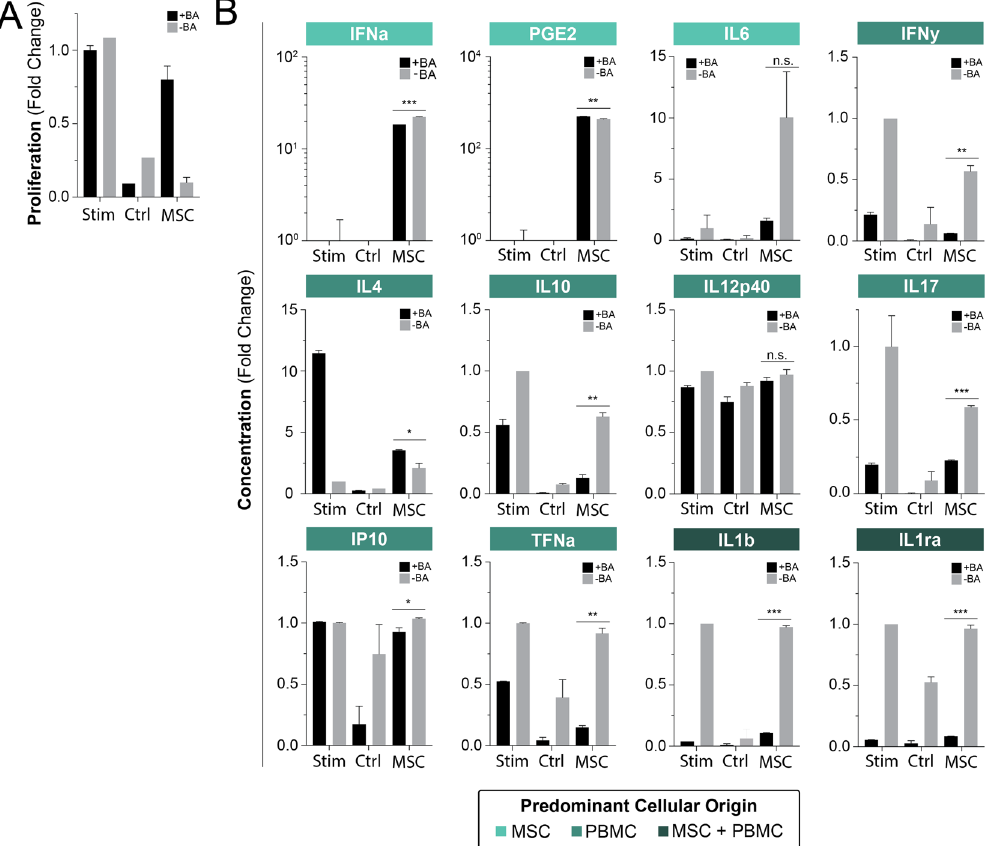
Figure 5. MSC:PBMC cross communication is critical as shown by the use of a protein transport inhibitor. PBMCs were treated for 24 hours with Brefeldin A prior to the start of co-culture; + BA indicates with brefeldin A pretreatment, -BA indicates without brefeldin A pretreatment. PBMC proliferation was attained through stimulation with ConA and IL2 for a period of 4 days. Proliferation was measured through flow cytometry and CFSE staining; bar graphs represent mean + / − SD of 3 samples. ( A ) Bar graphs of normalized proliferation versus Brefeldin A conditions. ( B ) Bar graphs of normalized cytokine secretion versus Brefeldin A conditions. Two-group significance comparisons were performed with a student’s T-test; n.s., no significance; * P ≤ 0.05; ** P ≤ 0.01; *** P ≤